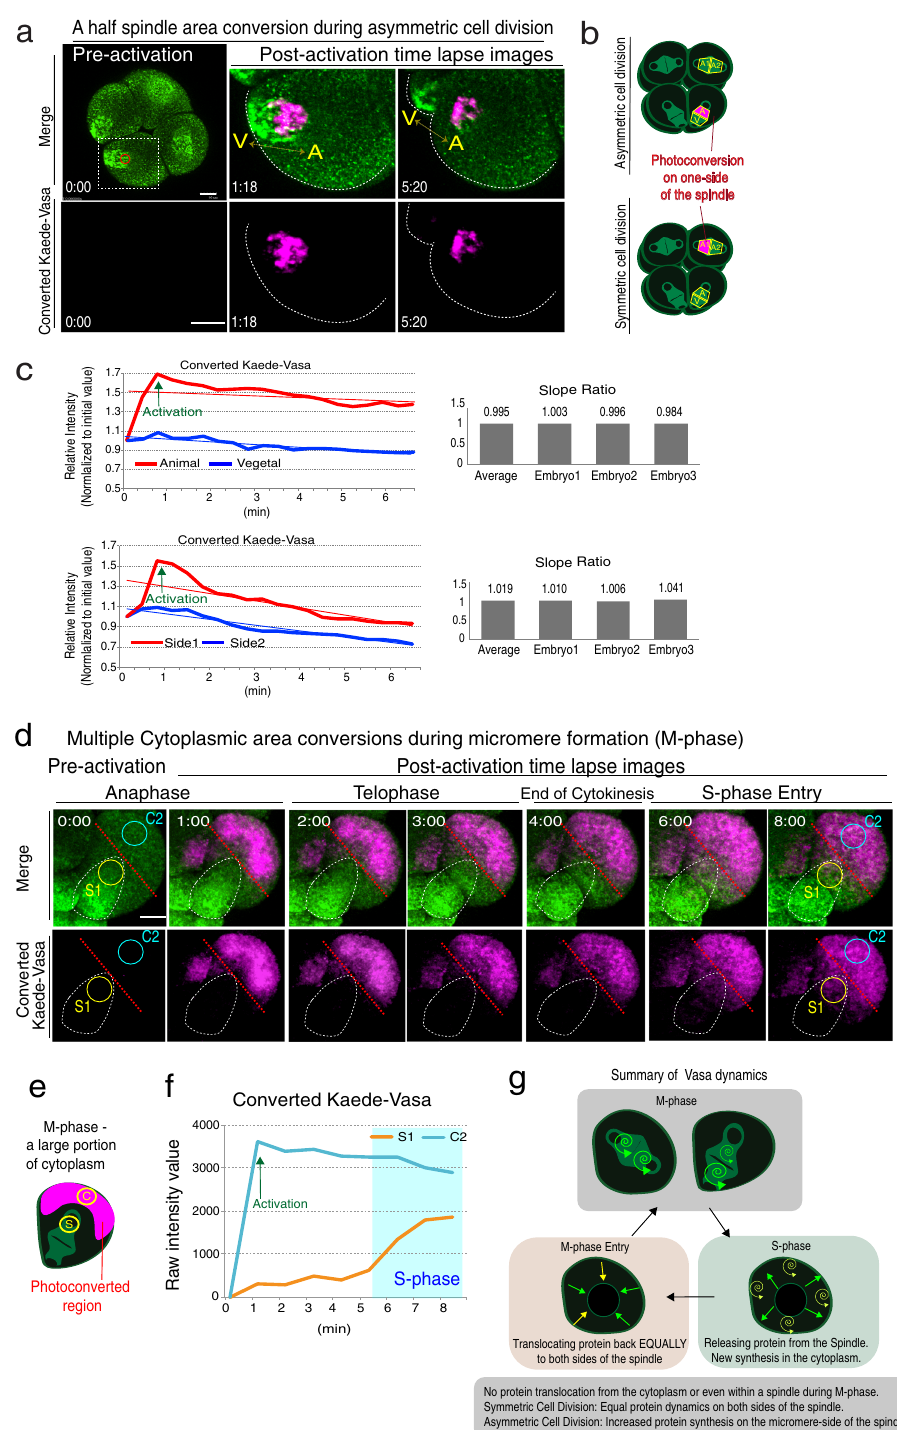
incorporation on the spindle was ~1.85-fold higher (Fig. 4d, e; ~59% of the total protein is on the spindle region) than in the areas occupied by the spindle region versus the cytoplasm, and the background level measured in the presence of emetine, a translation blocker, the spindle area generates ~1.45-fold (~46.5%) more protein synthesis than random areas of the cytoplasm.